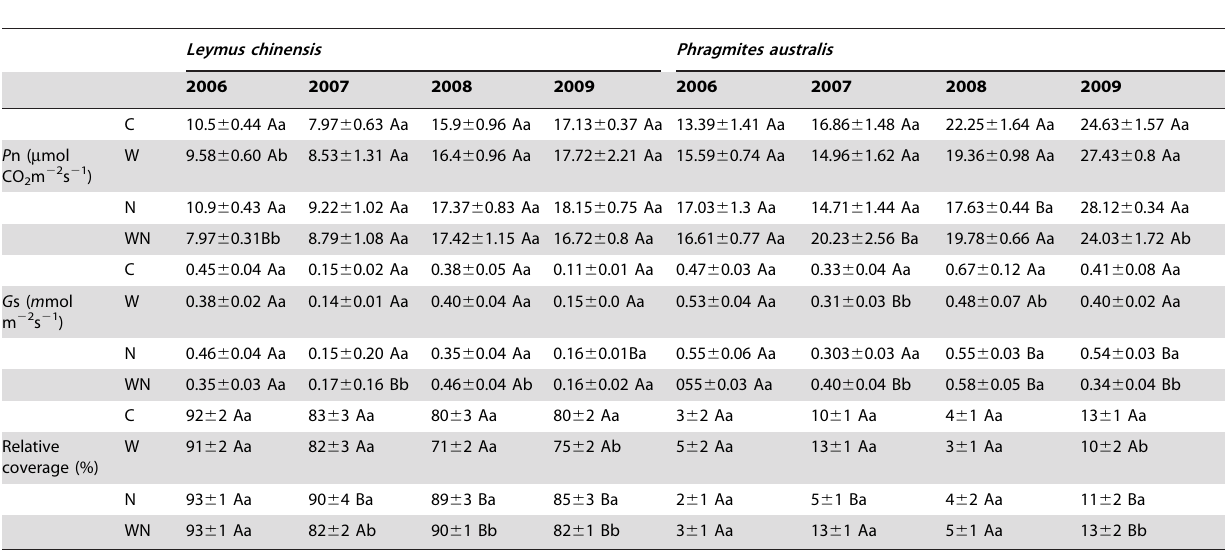
Table 3. Net photosynthetic rate ( P n), stomatal conductance ( G s) and relative coverage (mean 6 SE) of Leymus chinensis and Phragmites australis measured in June of 2006, 2007, 2008 and 2009.